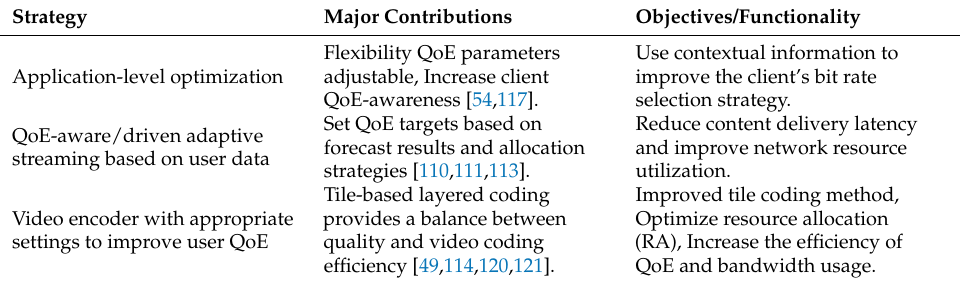
Table 5. Summary of QoE-oriented VR optimization